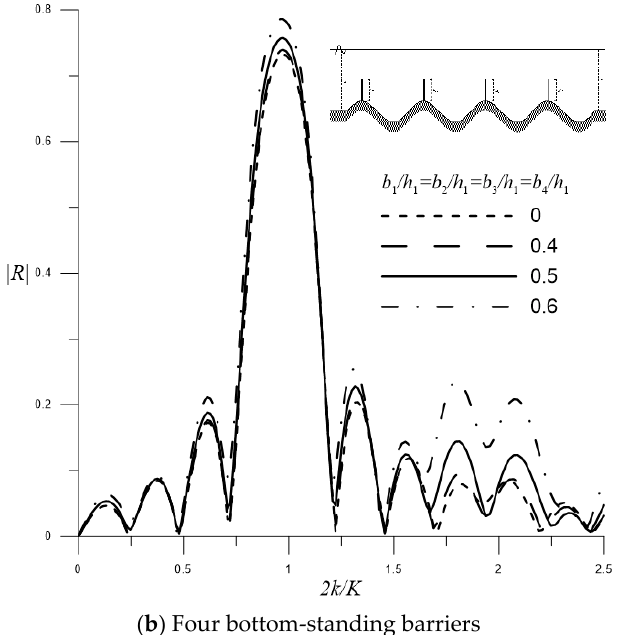
Figure 17. Reflection coefficient | R | varying against 2 k / K for the four ( a ) surface-piercing and ( b ) bottom-standing barriers with different barrier lengths.